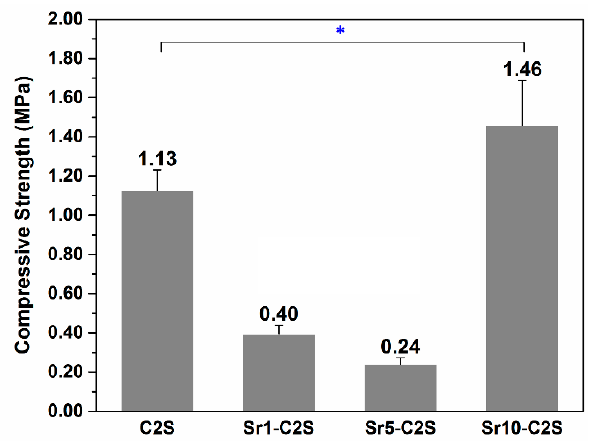
Figure 7. Compressive strength of C2S and Sr-C2S bone cement after curing in a constant-temperature shaking water bath at 37 °C, 100% humidity for 14 days. * denotes significant difference exists between the two groups.